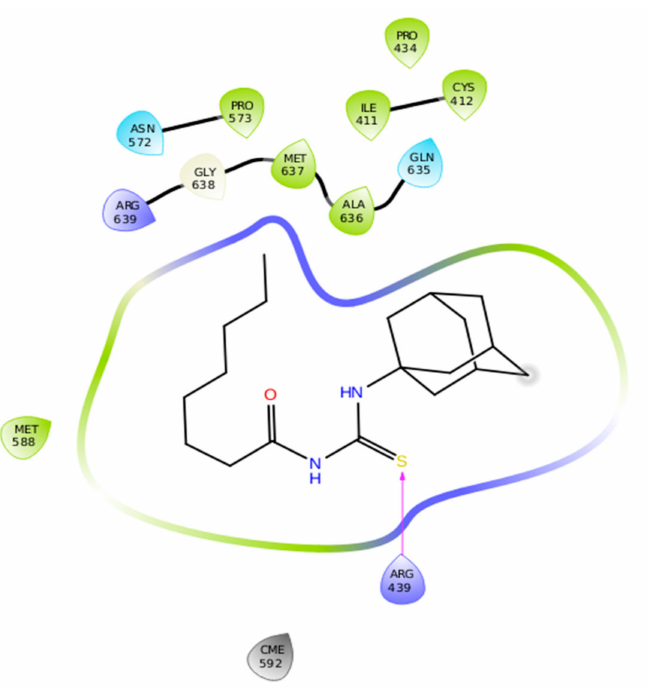
Figure 7. 2D depiction of 3j docking complex. The docking of the most potent derivative 3j has been performed against target enzyme PDBID 4H9M in order to find a binding pocket other than the catalytic site to assure a non-competitive binding mode with respect to the inhibitor. It has been observed that -NH of thiourea moiety of the compound 3j forms two hydrogen bonds with amino acid residue VAL391 having binding distance 1.858 Å and 2.240 Å (Figure 8). As the most potent derivative 3j binds well with the amino acid located outside the enzymatic catalytic pocket, we may, thus, propose that it is non-competitive mode of